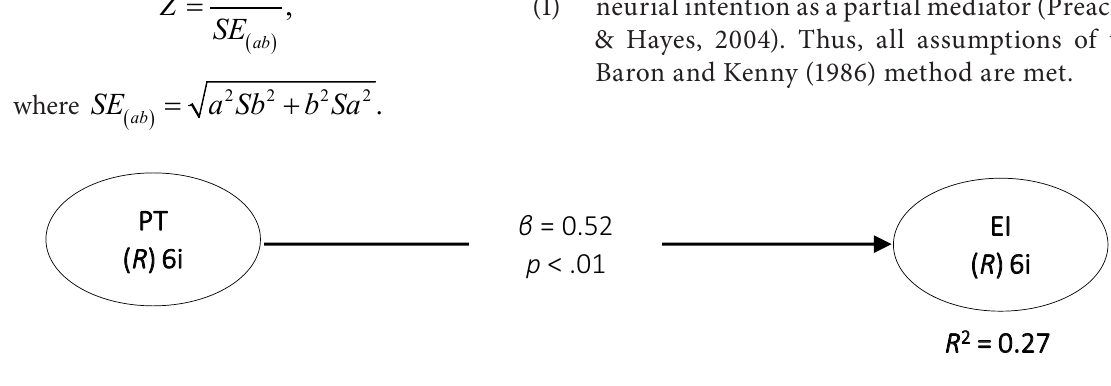
Figure 2. PLS result for direct